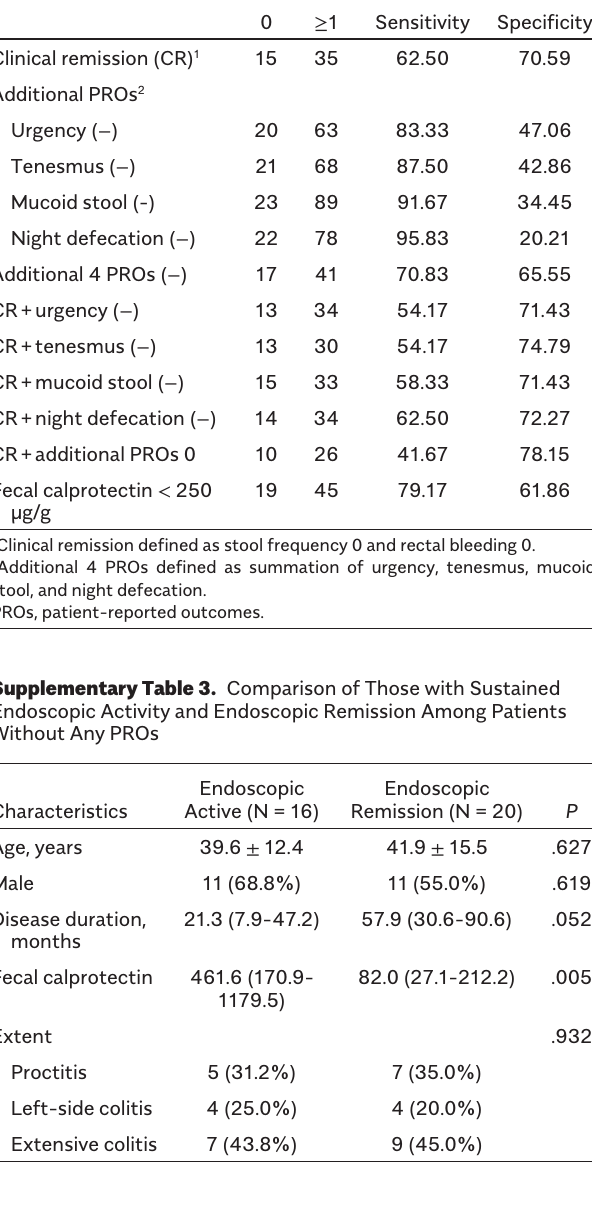
Supplementary Table 1. Subgroup Analysis Depending on Disease Duration (Longer than 3 Years) Patient-reported